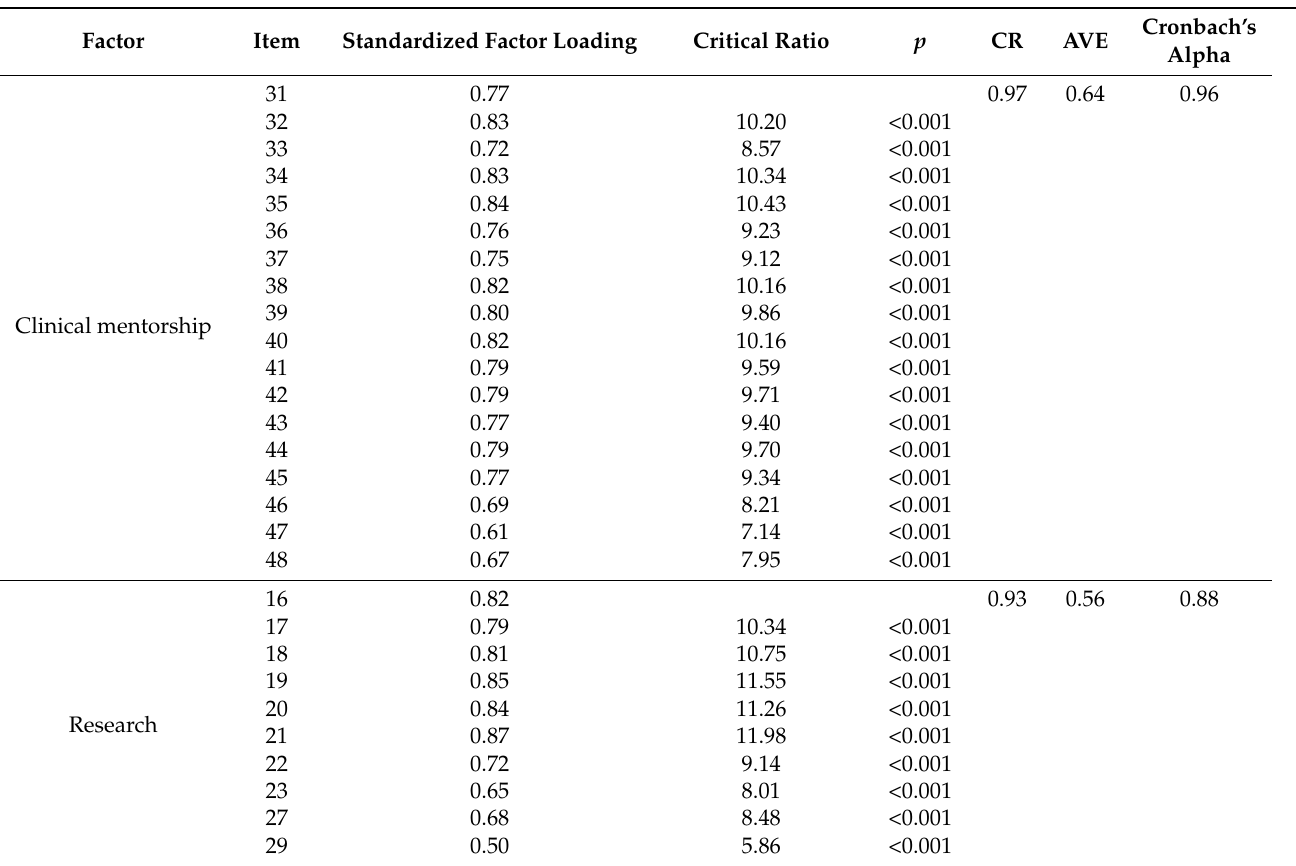
Table 5. Confirmatory factor analysis results of the SSNER-SL ( n = 126).